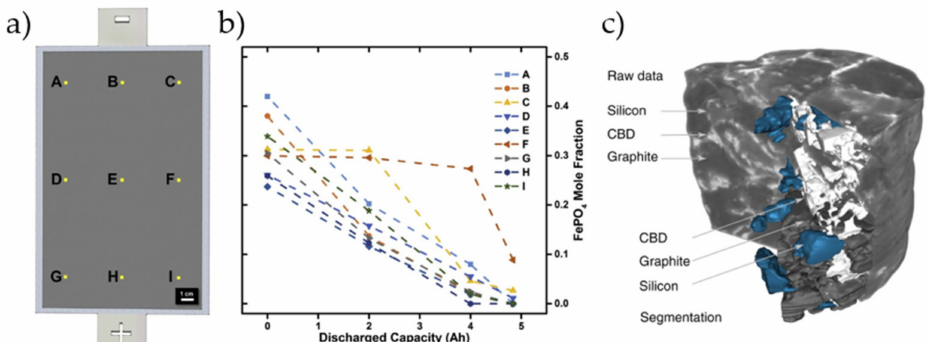
Figure 6. 3D reconstruction of electrodes: ( a ) Location of bulk measurement points, and ( b ) spatial inhomogeneity during discharge in LFP pouch cell. Reproduced with permission from [59] Copyright 2015, Elsevier. ( c ) The 3D-reconstruction of tomographic raw data and segmentation of silicon-graphite anode from a transmission X-ray tomographic microscope. Scale bar 15 µ m. (CC BY 4.0 Müller et al. [124]).